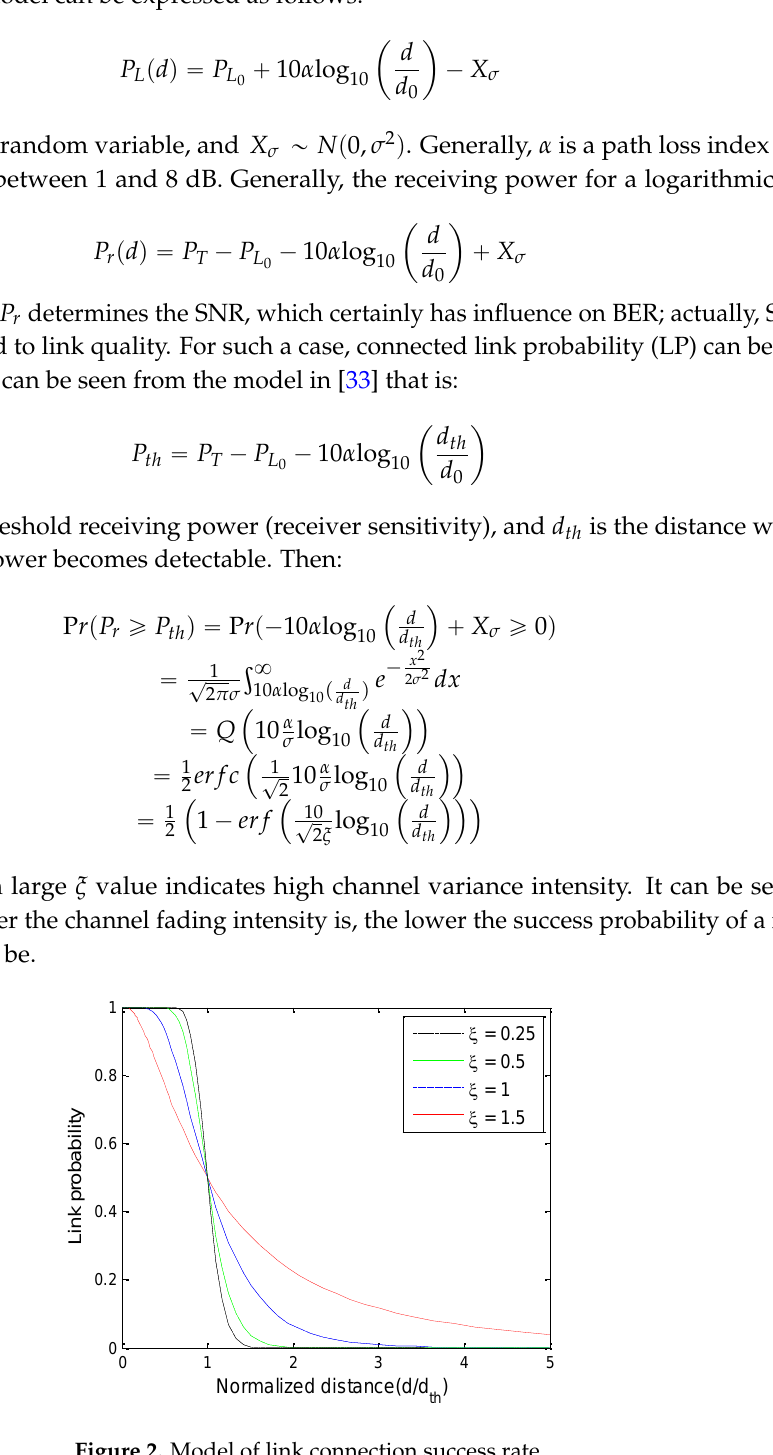
Building cluster T Figure 3. Time axis diagram for the three stages of the clustering protocol.